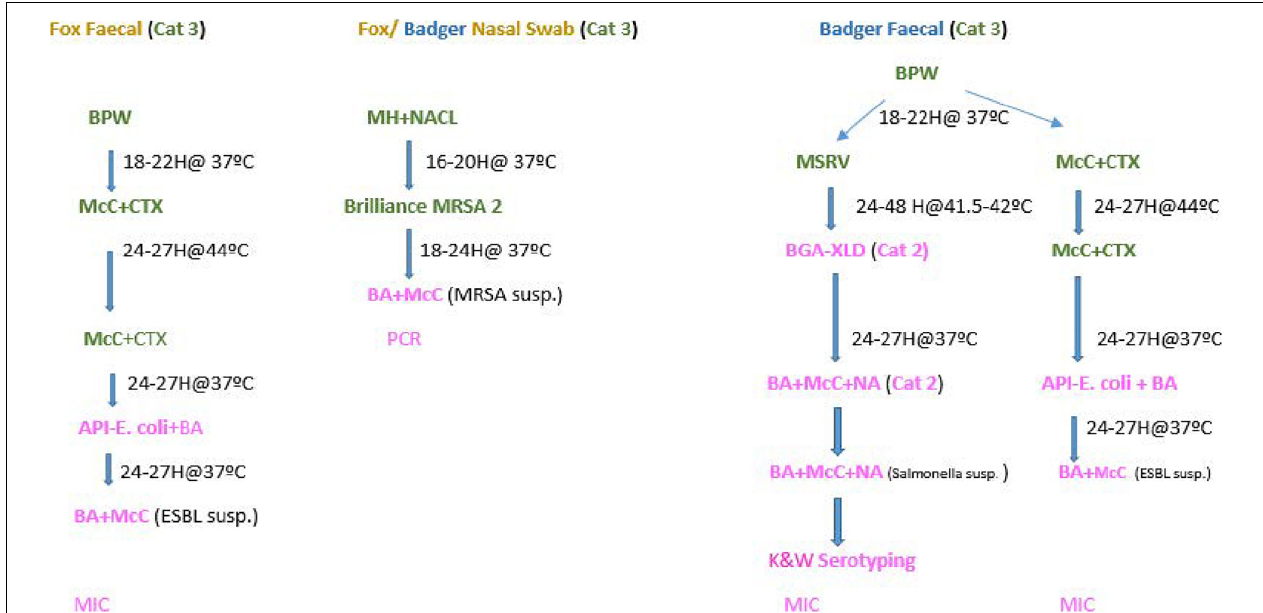
FIGURE 1 | Flow chart- Microbiological processing of faecal and nasopharyngeal swabs collected from foxes and badgers